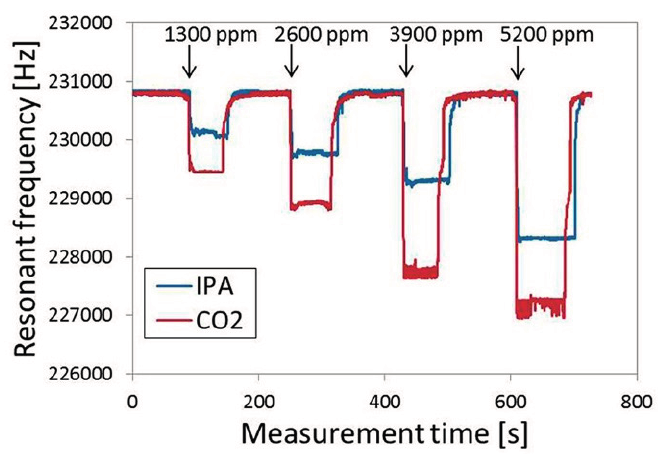
Figure 19. Real-time gas sensing response of the ZIF-loaded resonator to IPA and CO 2 . Reprinted with permission from